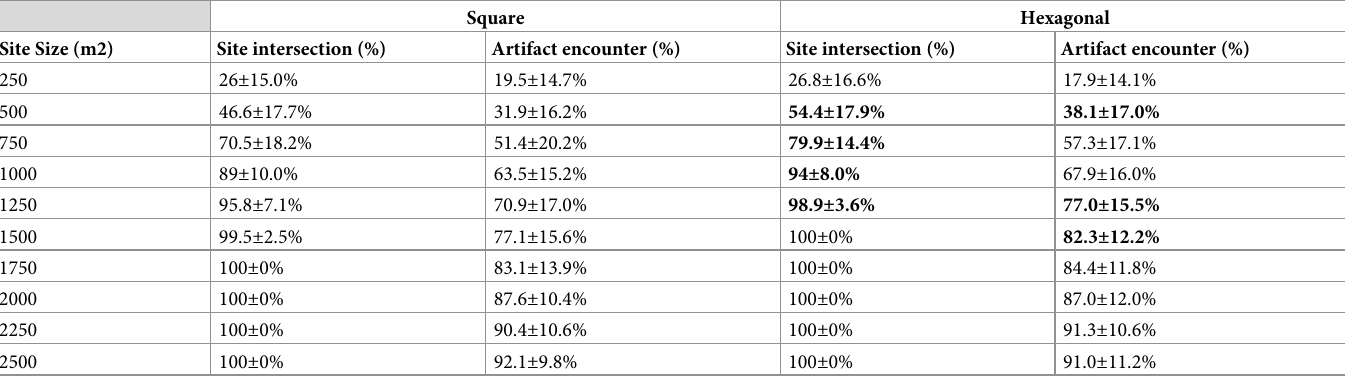
Table 3. Comparison of square and hexagonal grid